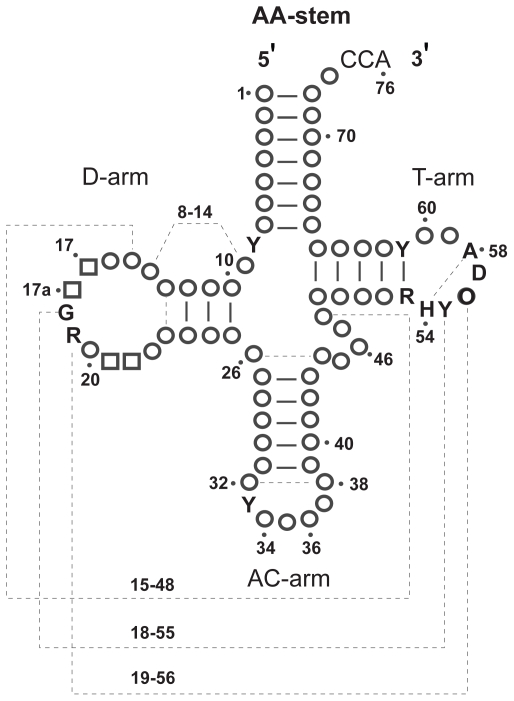
Canonical schematic of the tRNA cloverleaf secondary structure (Marck and Grosjean, 2002).